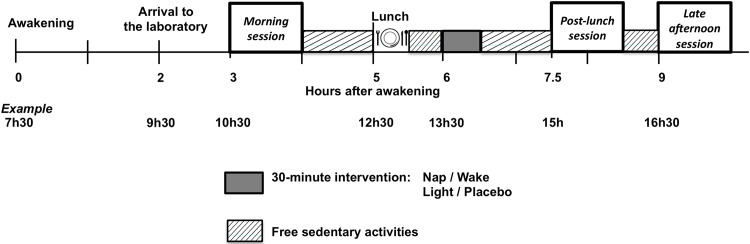
Schematic representation of one session (wake or nap, bright light exposure or placebo) of the protocol.Each pair of sessions was scheduled according to the participant’s sleep schedule and wake up time. An example of the timings is shown for a person waking up at 7:30am.